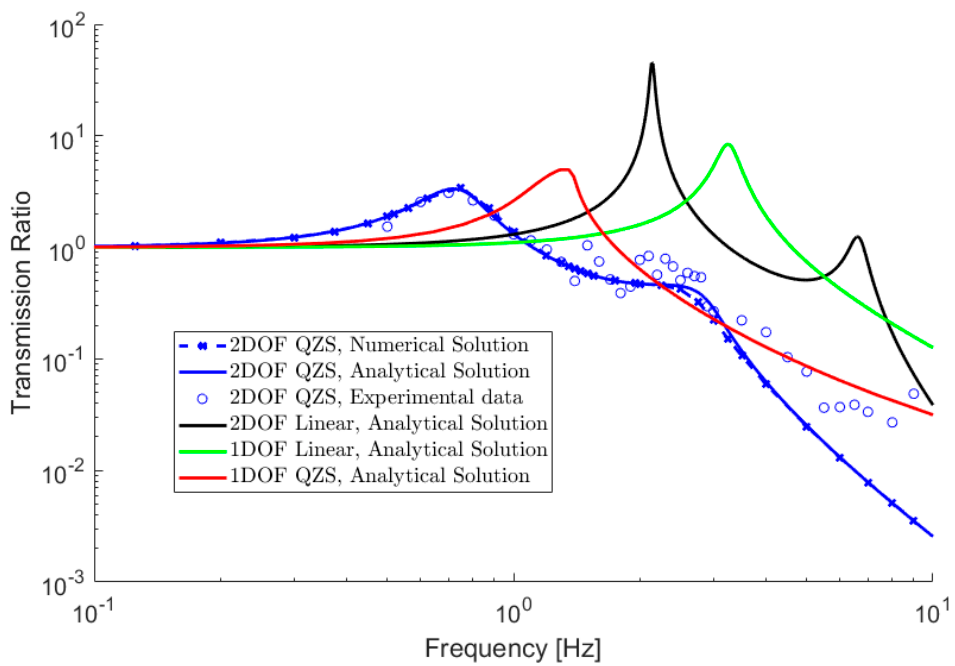
Figure 8. Transmissibility plot of the 2DOF prototype, along with the predicted response using numerical and analytical approaches for ζ 1 = 0.04 and ζ 2 = 0.06. The theoretical plots of other configurations are also included for a better comparison.